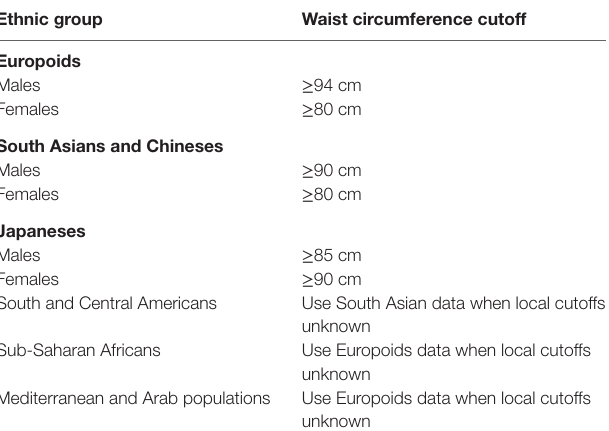
TaBle 3 | Cutoff values for waist circumference, by ethnic group, for the definition of central obesity in the International Diabetes Federation criteria (2005) (19).